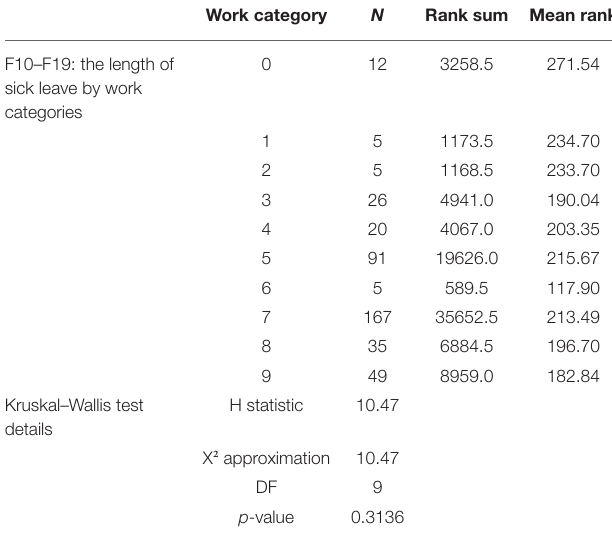
TABLE 3 | Kruskal–Wallis test results: the length of sick leave related to mental illnesses caused by drugs (alcohol, tobacco, illicit drugs), in the study sample